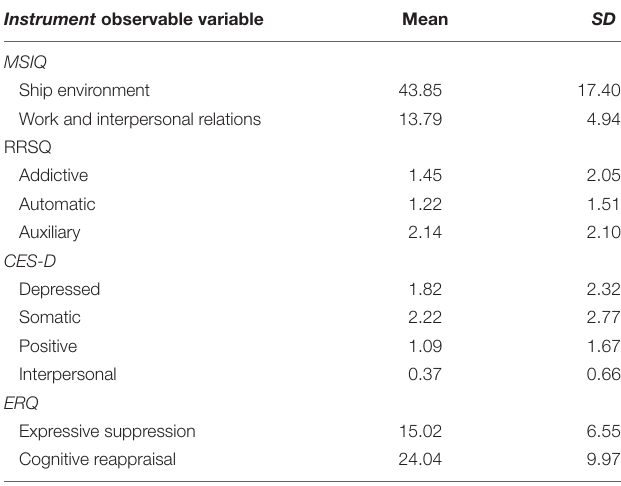
TABLE 2 | Descriptive statistics for all observable